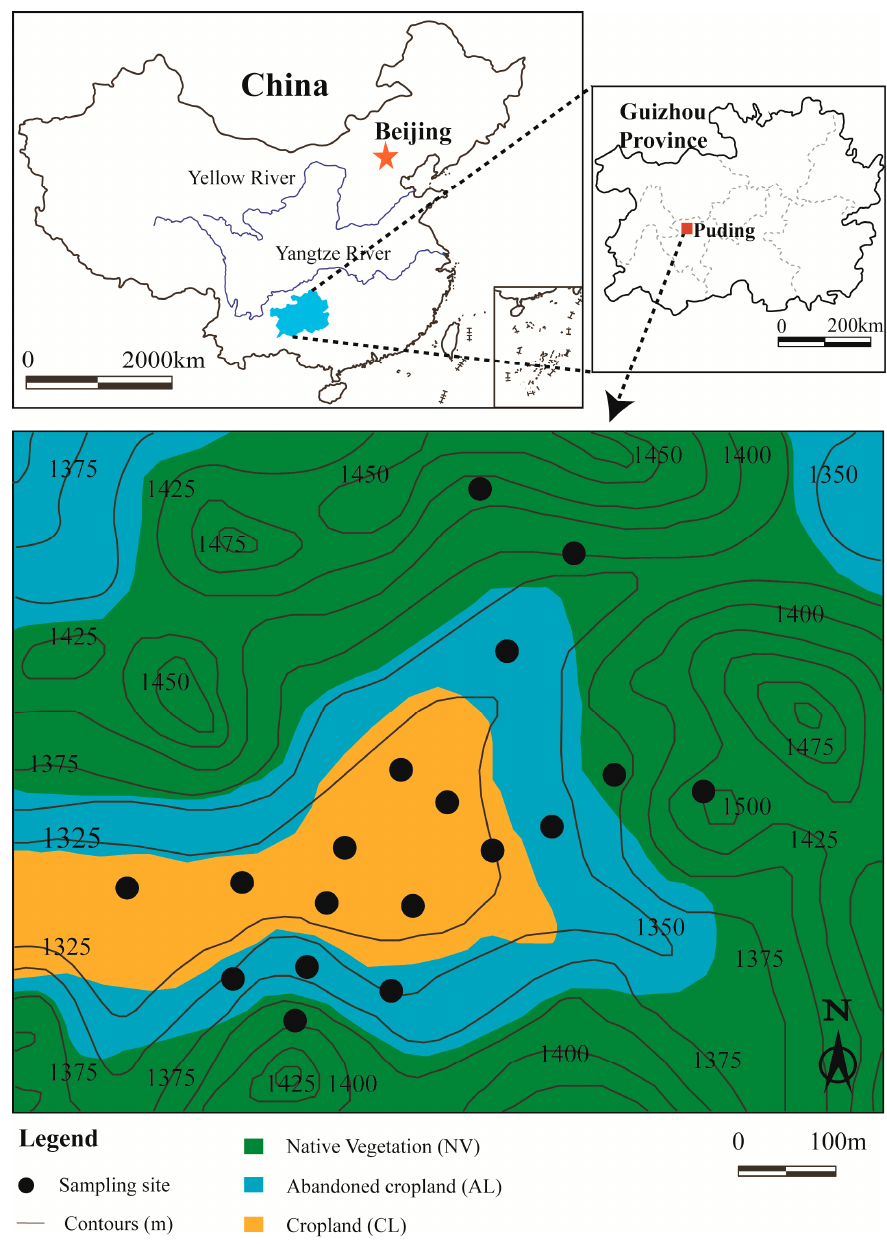
Figure 1. Location of study area and sampling sites.